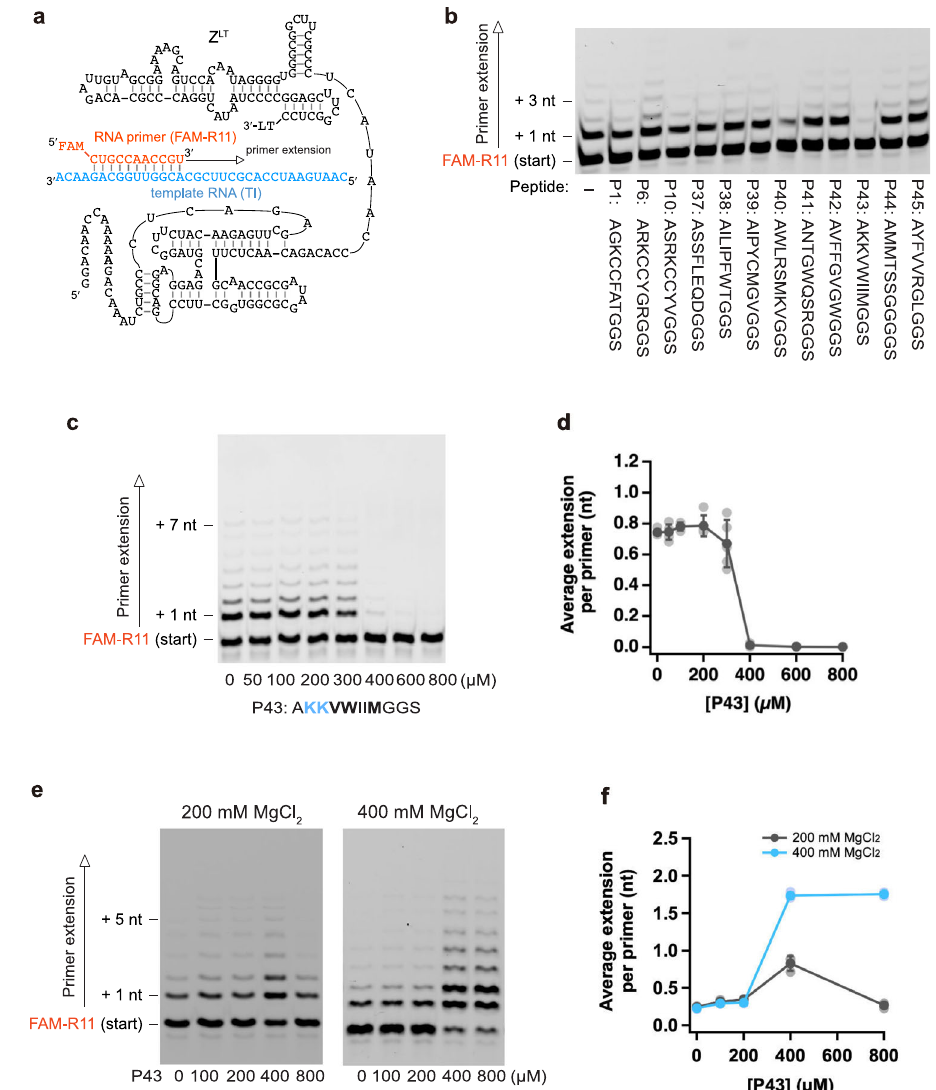
Fig. 1 Selection of ribozyme-binding peptides. a Schematic depiction of an RNA polymerase ribozyme (RPR Z LT ). 3 ′ -LT is a 3 ′ -extension sequence (GCGGCCGCAAAAAAAAAAGGCUUACC) used in the previous ribozyme selection for RPR Z 11 . b – f Primer extension by RPR Z LT at low [Mg 2 + ] was performed in 50 mM Tris • HCl (( b ) pH 7.6, ( c , d ) pH 8.3) buffer containing 25 mM MgCl 2 , 8% PEG 6000, 0.4% DMSO and 500 µ M of each NTP. The reactions were incubated at 17 °C for 7 days. Primer extension by RPR Z LT at high [Mg 2 + ] was performed in 50 mM Tris • HCl (pH 8.3) buffer containing 200 or 400 mM MgCl 2 , 0.4% DMSO and 500 µ M of each NTP. The reactions were incubated at 17 °C for 3 days. b The peptide concentration was 0.4 mg/mL (P1: 400 µ M; P6: 350 µ M; P10: 350 µ M; P38: 340 µ M; P39: 380 µ M; P40: 340 µ M; P41: 360 µ M; P43: 340 µ M; P44: 420 µ M; P45: 360 µ M) except for P42, which was used as a 0.04 mg/mL (37 µ M) mixture. d , f Data are presented as mean values ± S.D. ( N = 5 ( d ) or 3 ( f